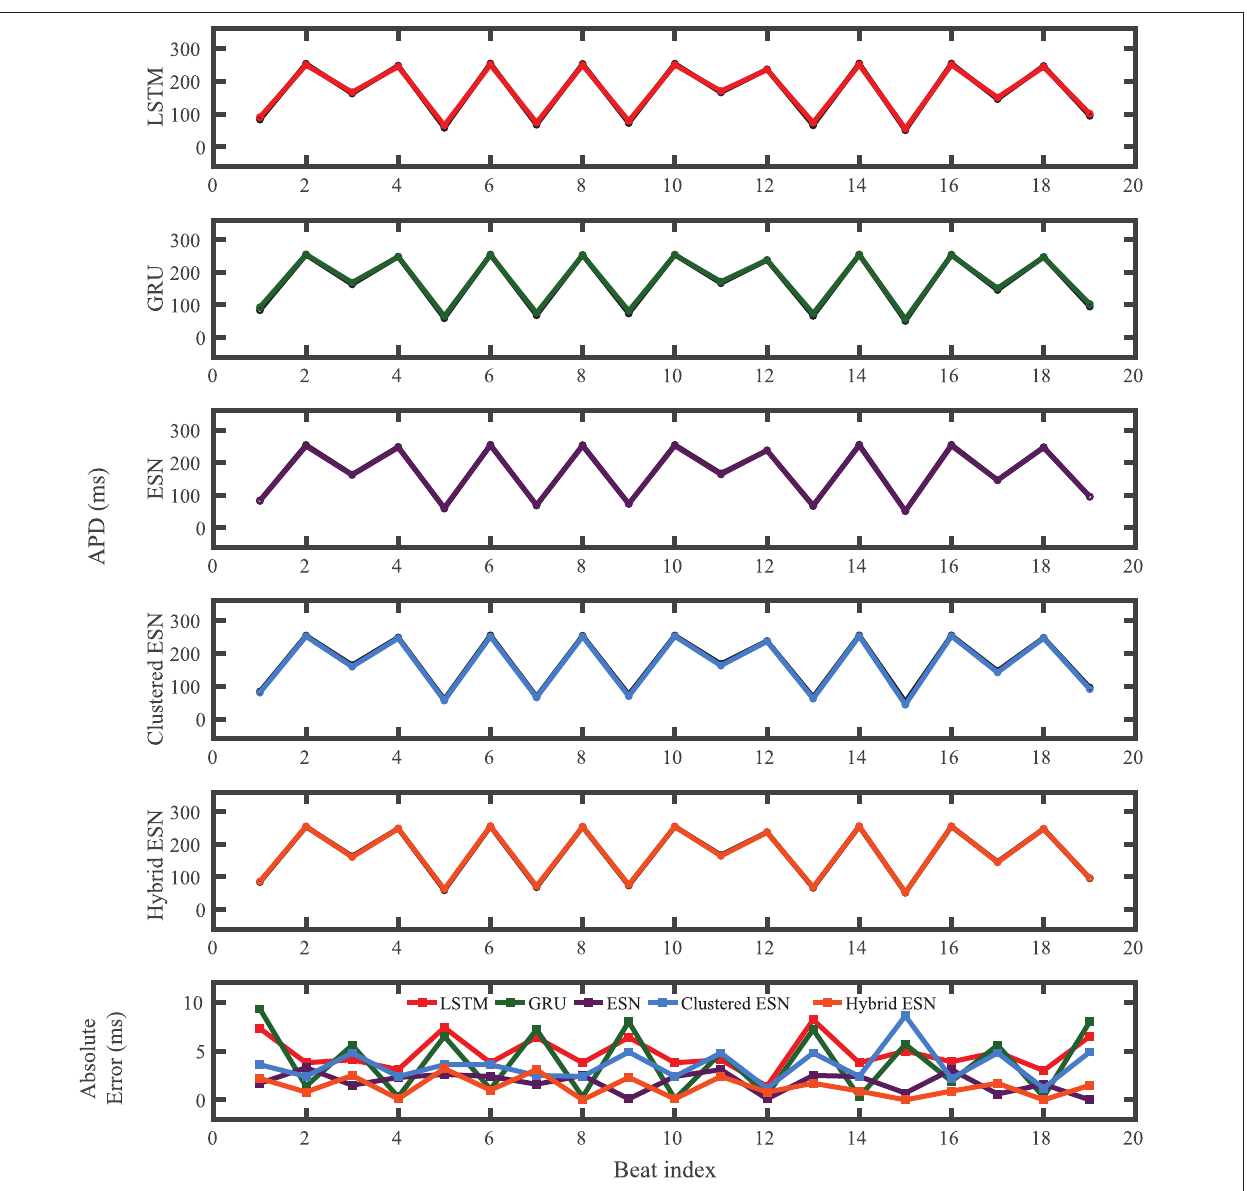
FIGURE 5 | FK dataset APD prediction results obtained for the five methods using a fixed network size of 100 neurons. APDs from data used for testing are shown in black for reference and predicted APDs are shown in color. Absolute error in APD prediction is shown in the bottom subplot, with color corresponding to prediction